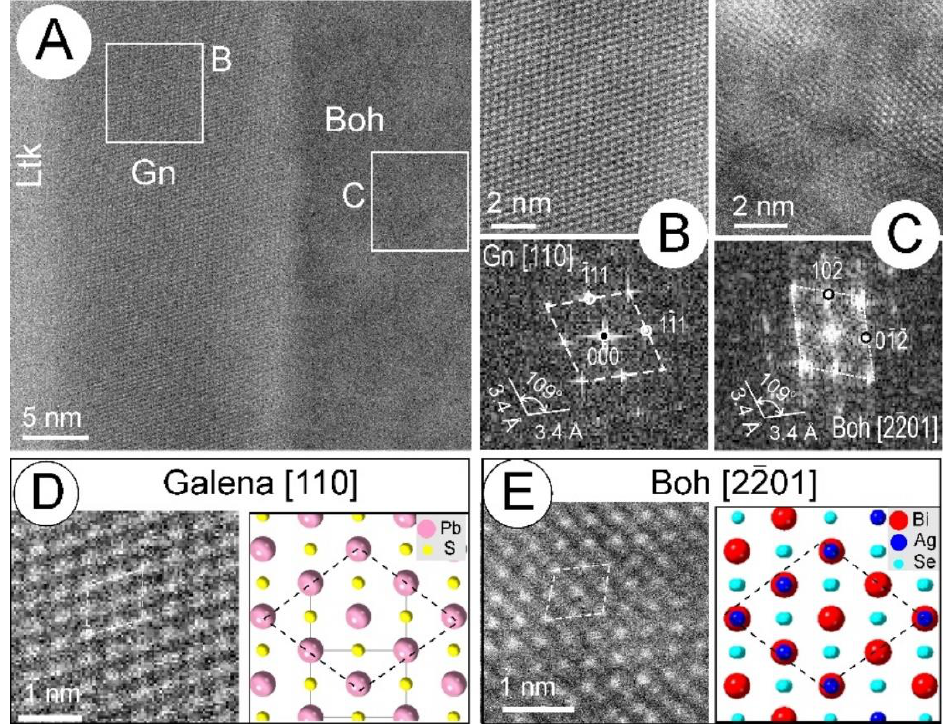
Figure 13. ( A–C ) HAADF STEM images and FFT patterns of galena (Gn) and bohdanowiczite (Boh) within laitakarite (Ltk), occurring along the composite inclusion shown on the maps in Figure 11. These are imaged on zone axes as marked on the FFT patterns. ( D , E ) crop of images in ( B ) and ( C ) and crystal models of the two phases. Overlays (dashed white lines) on the FFT patterns, images, and models highlight the rhombus motif which is common to both species for the respective zone axes.